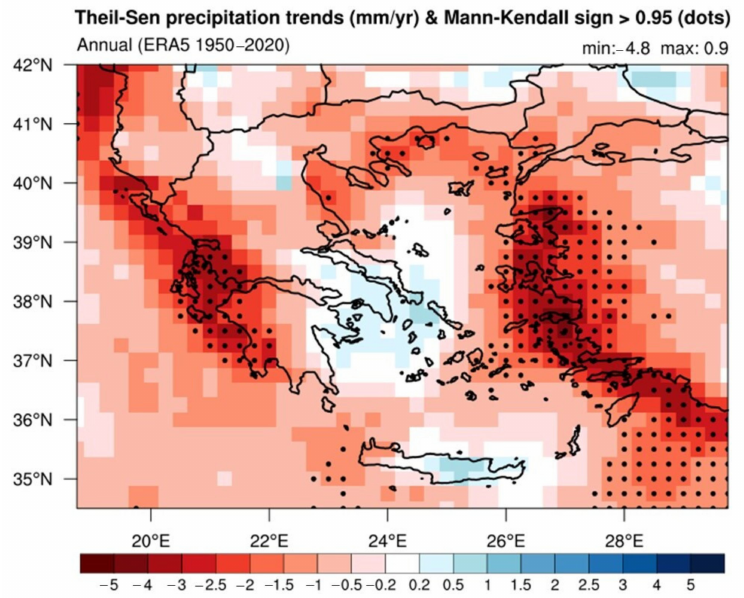
Figure 5. Spatial distribution of Theil–Sen trends for annual precipitation (mm/yr) during the period 1950–2020. Dots on maps indicate significant trends at the 95% significance level.